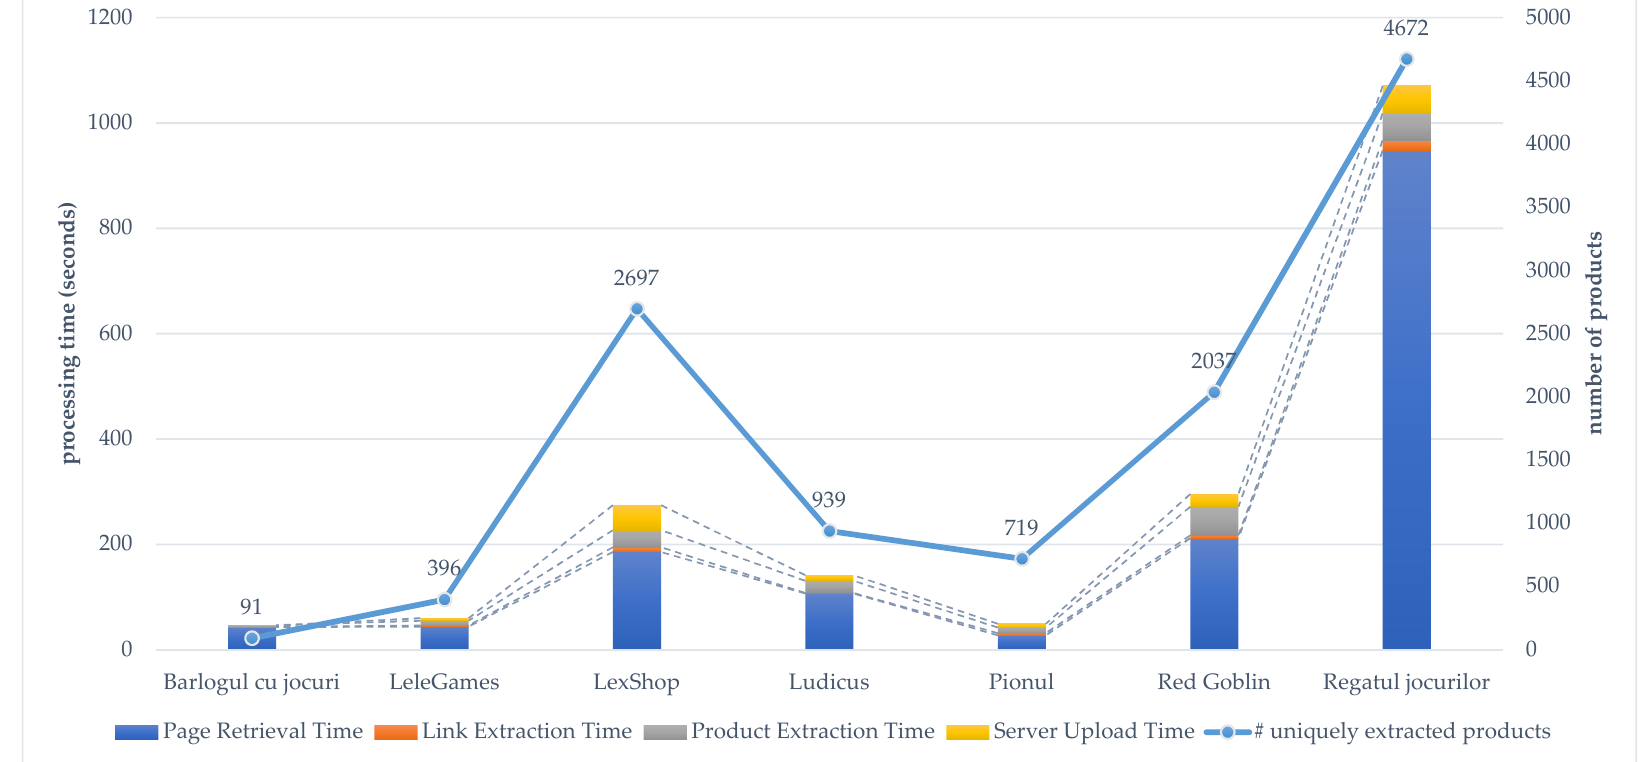
Figure A1. Total sum of processing times (i.e., page retrieval, link extraction, product extraction, and server upload times) in relation to the total number of extracted products from each of the seven considered websites.